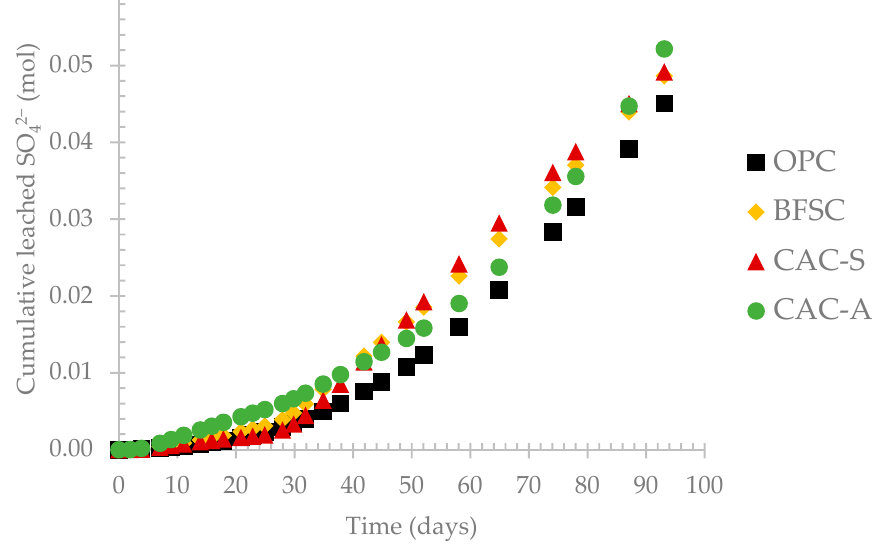
Figure 5. Evolution of the sulfate concentration in the leaching solution during the exposure pe- riod.